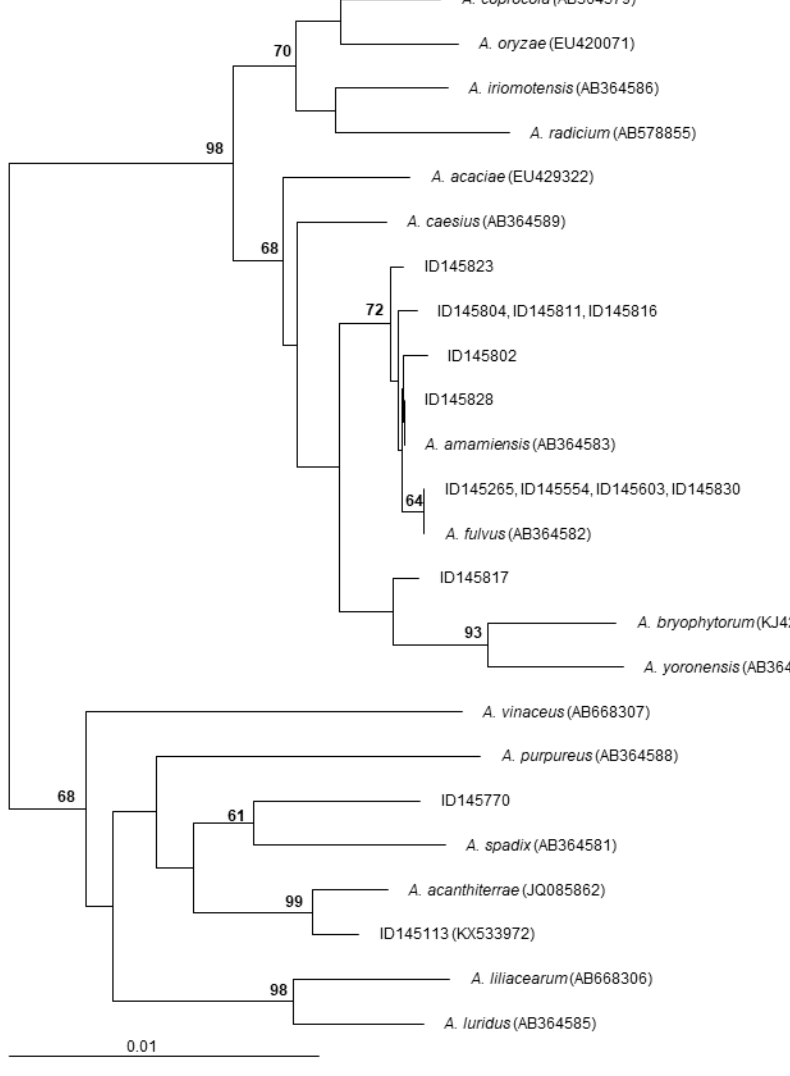
Figure 6. Neighbor-joining tree showing the phylogenetic position of polyether-producing Actinoallomurus strains. Type-strains of all described Actinoallomurus species are included. The sequence of the paramagnetoquinone producer Actinoallomurus sp. ID145113 is also included. The tree is based on 1309 unambiguously aligned positions in the 16S rRNA gene sequences. Numbers at the nodes are bootstrap values based on 100 resamplings; only values higher than 60 are shown. Scale bar represents 1 inferred substitutions per 100 nucleotides. The tree was rooted using Streptosporangium roseum 16S rRNA gene sequence (X89947) as outgroup.